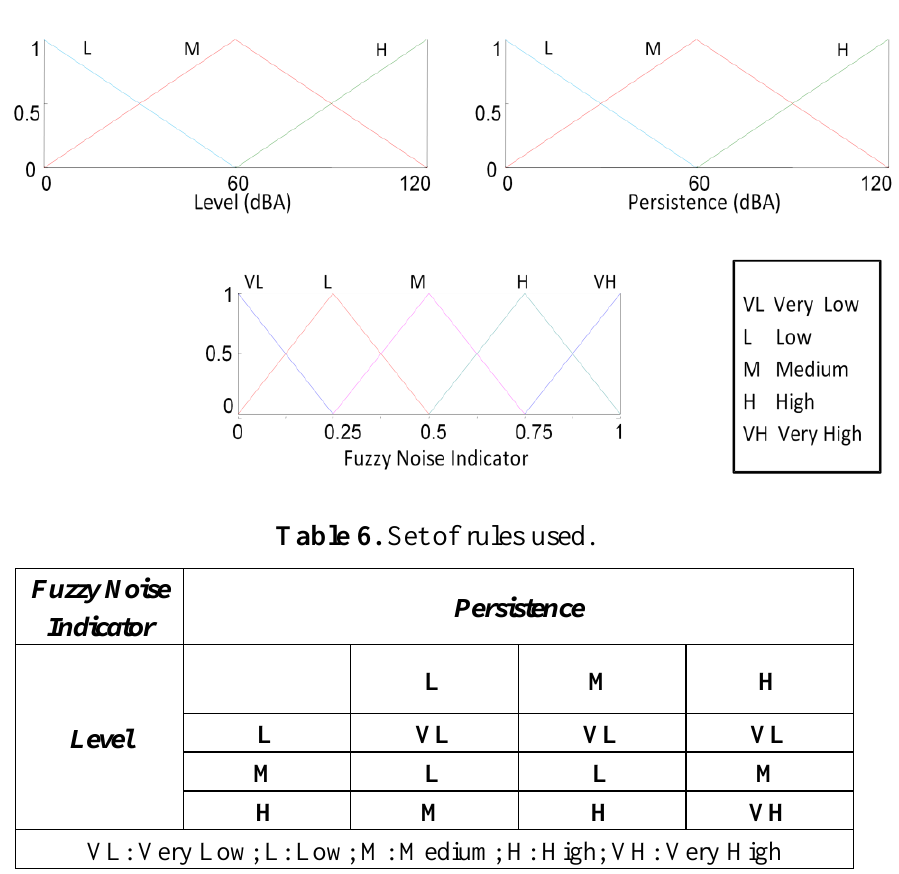
Figure 10. Membership functions of the inputs and output variables fuzzy sets.